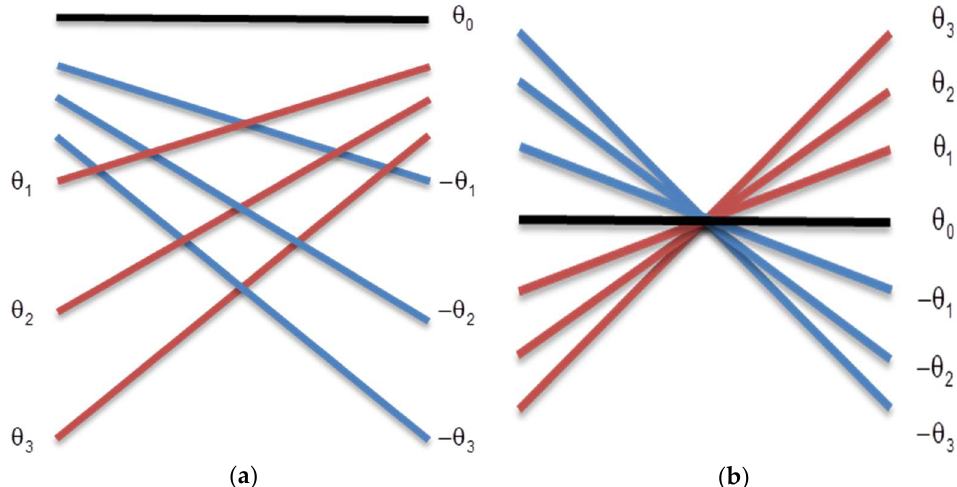
Figure 3. Coherent plane wave technique where all transducer elements are excited with different angles. ( a ) Separated excitation angles. ( b ) Representation of a focal point by the intersection of excitation angles.